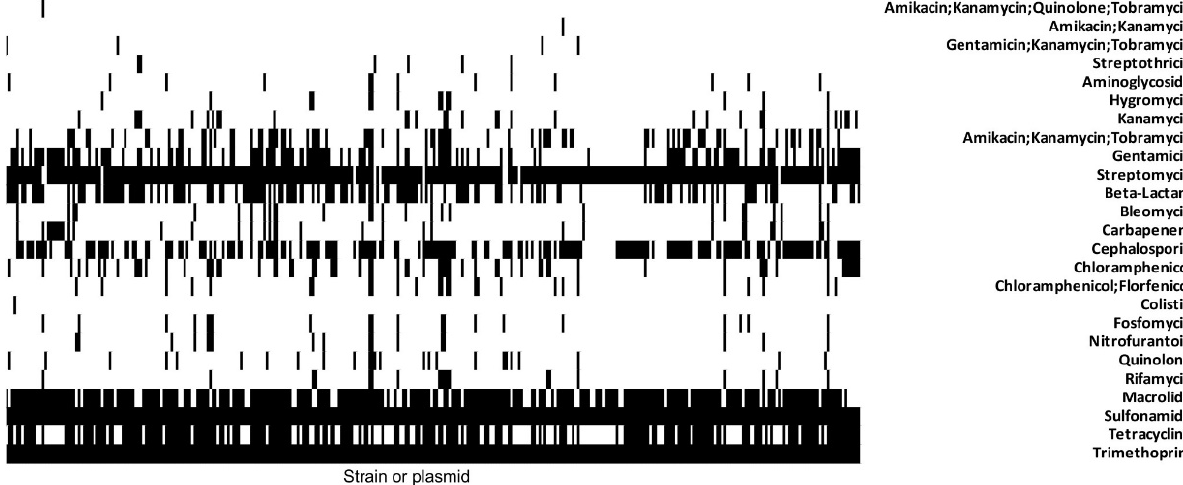
Figure 4. Presence-absence matrix to visualize parallel resistance in 332 enterobacterial isolates. The presence of resistance determinants conferring resistance to 17 groups of antibiotics was detected in silico ( black , resistance gene is present; white , resistance gene is absent).